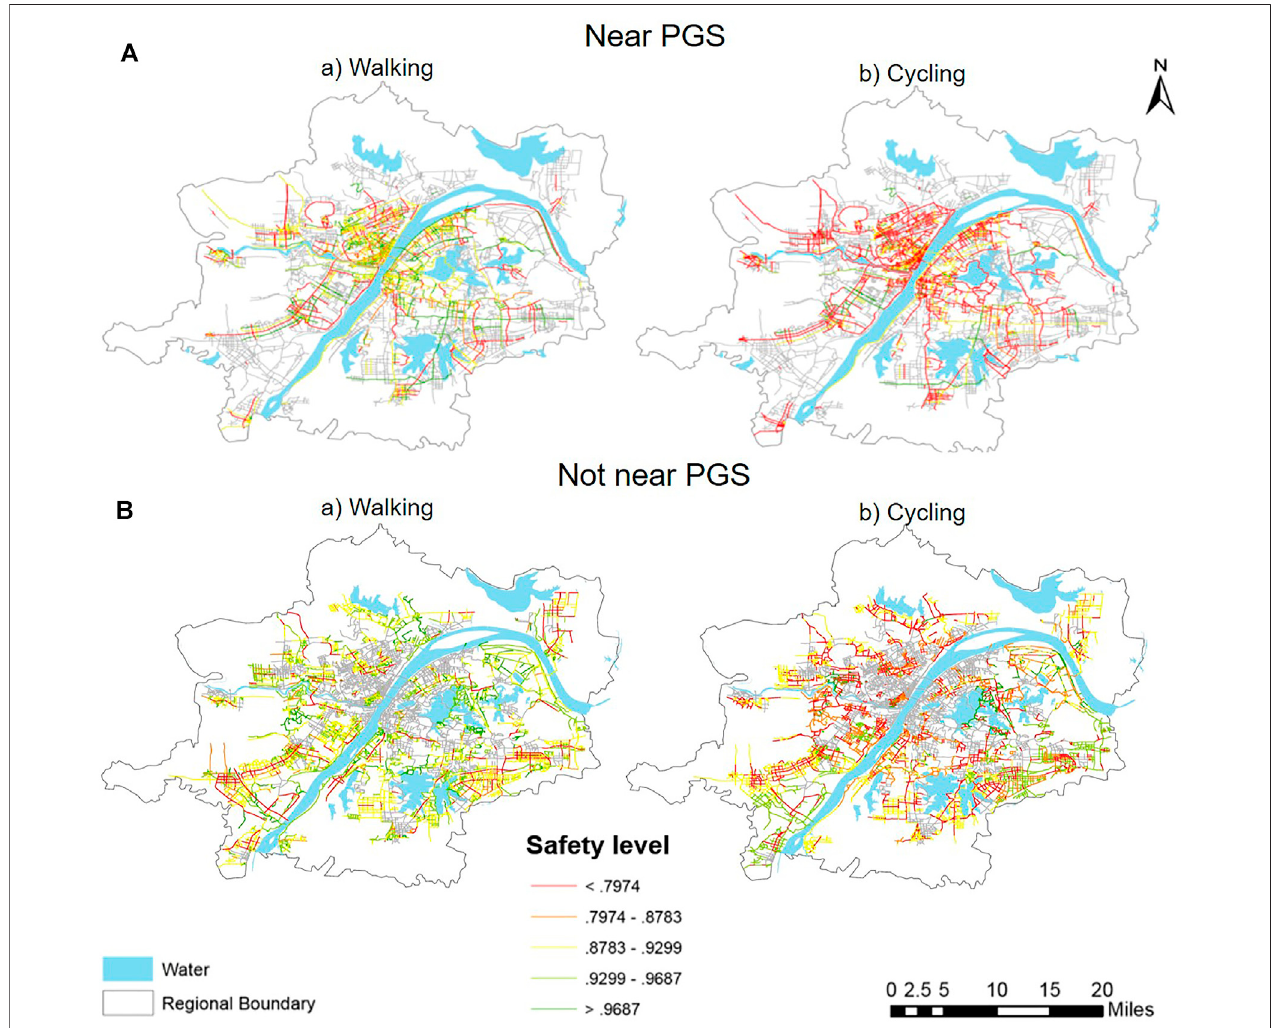
FIGURE 5 | Spatial disparity of ATTS (A) near PGS and (B) not near PGS.